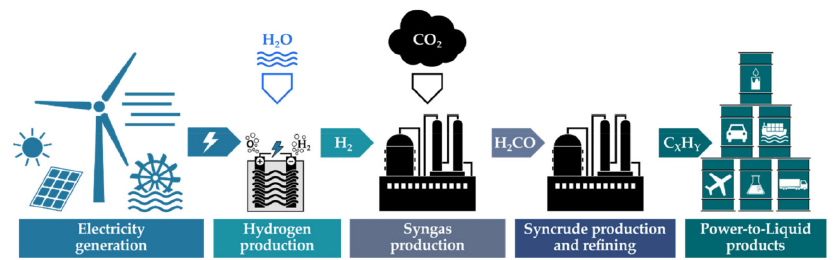
Figure 7. Generic scheme of a power-to-liquid process